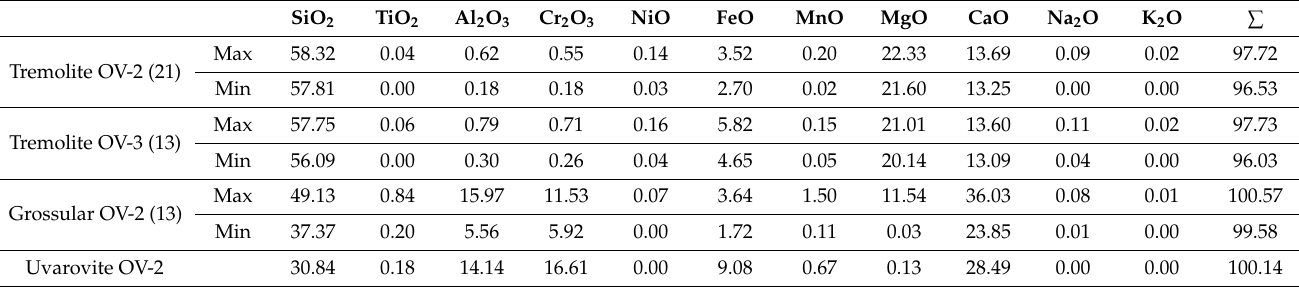
Figure 4. On the left, a sample of nephrite OV-2 is shown, while on the right, a sample of tremolite transitional rock OV-3 is shown. Table 1. Chemical composition of silicates (wt.